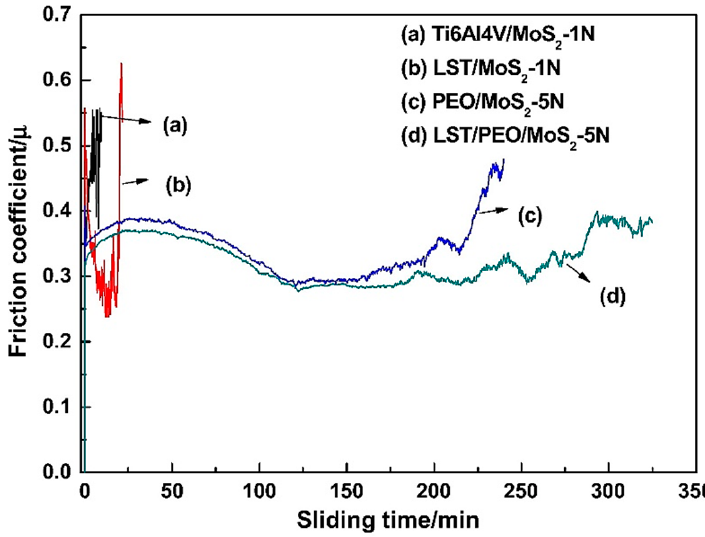
Figure 22. Friction versus sliding time graph for samples with addition of MoS 2 additive. Reproduced with permission from [174]. Copyright Elsevier, 2015.